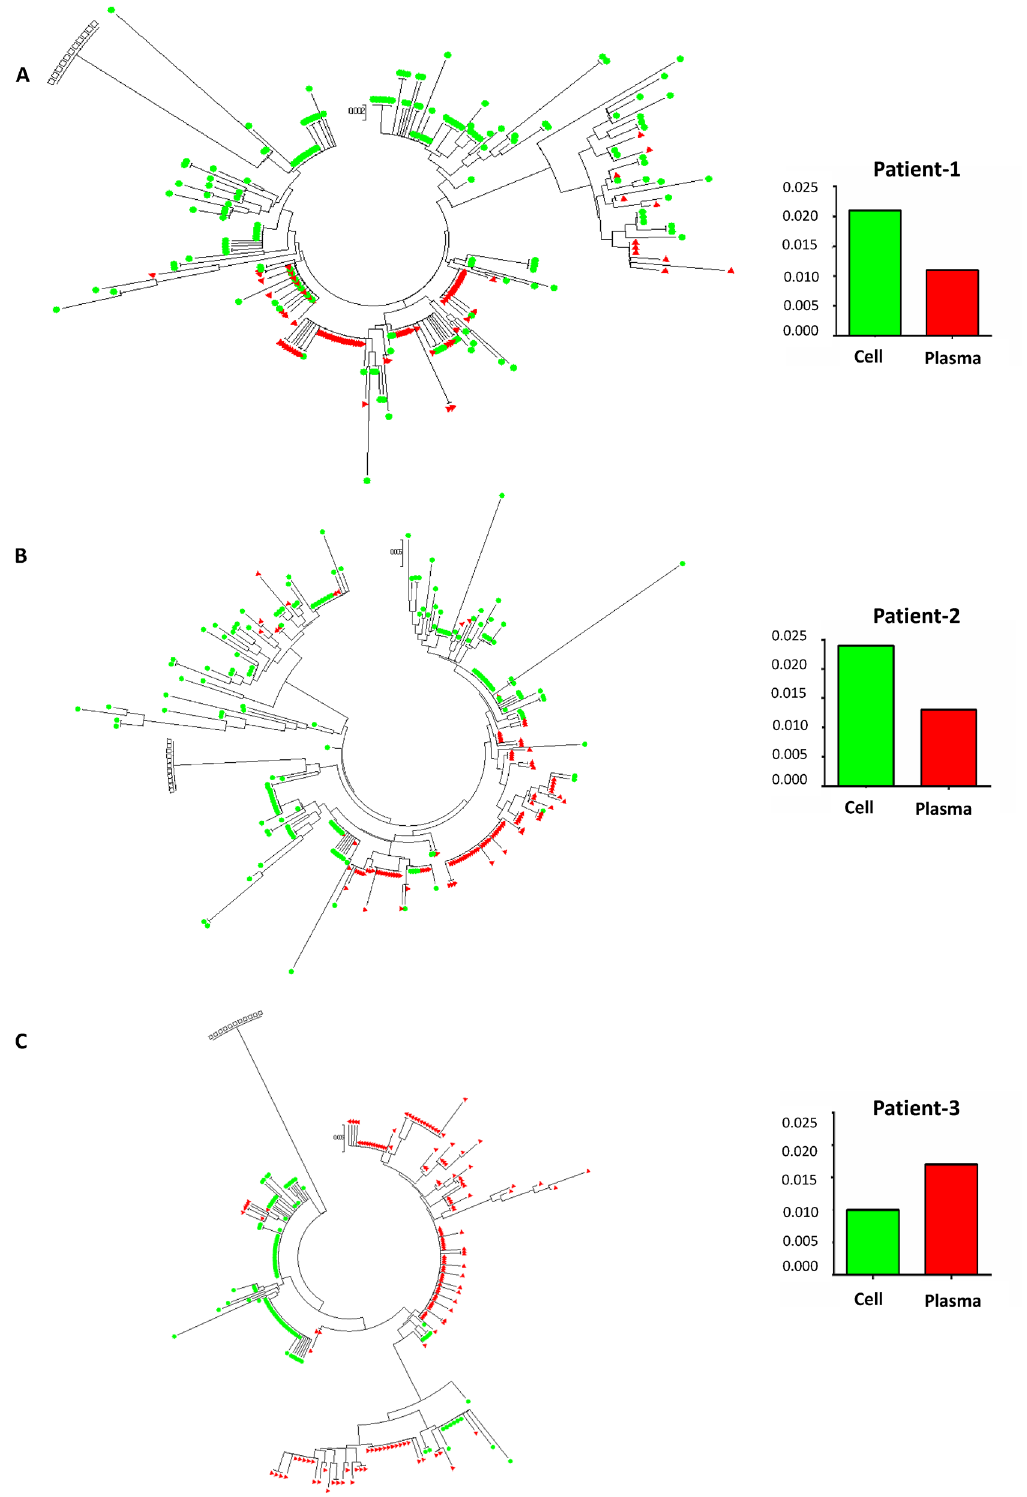
Figure 4. Phylogenetic analysis of the latent pro-viruses contributing to HIV rebound after analytical treatment interruption. ( A ) Patient 1; ( B ) Patient 2; ( C ) Patient 3. HIV protease sequences were obtained from DNA isolated from peripheral blood mononuclear cells obtained while patients were on antiretroviral treatment and maraviroc intensification during the initial study (green) and from plasma RNA after viral rebound at analytical treatment interruption during the amended study (red). Open squares represent the HIV reference sequence HXB2. Histograms represent the average pairwise distance (APD) between HIV sequences on cellular and plasma